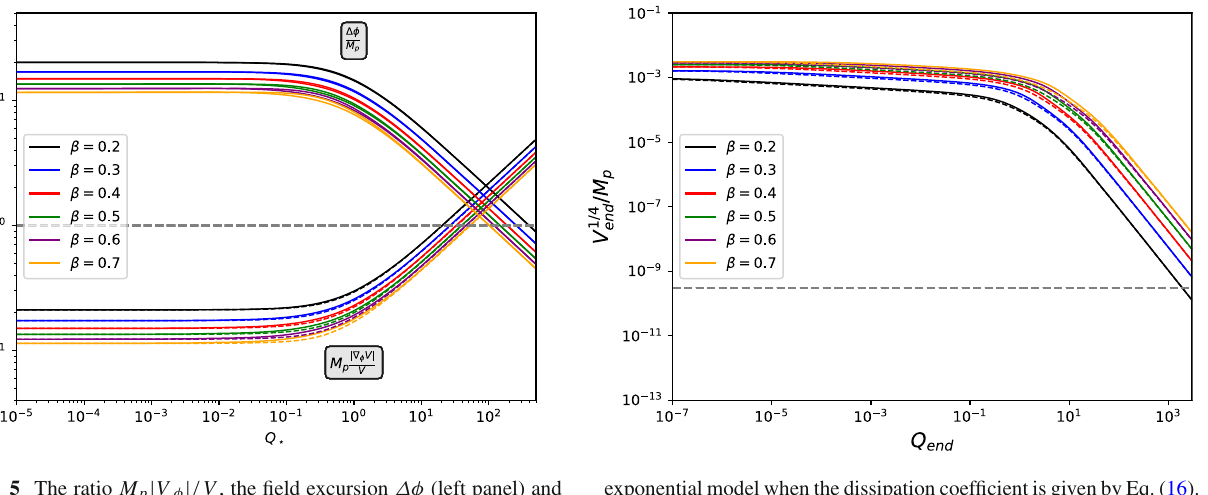
exponential model when the dissipation coefficient is given by Eq. (16). We have fixed λ = 0 . 05 (solid lines), λ = 0 . 07 (dashed lines) and have β - considered different β in the range β = 0 . 2 − 0 .